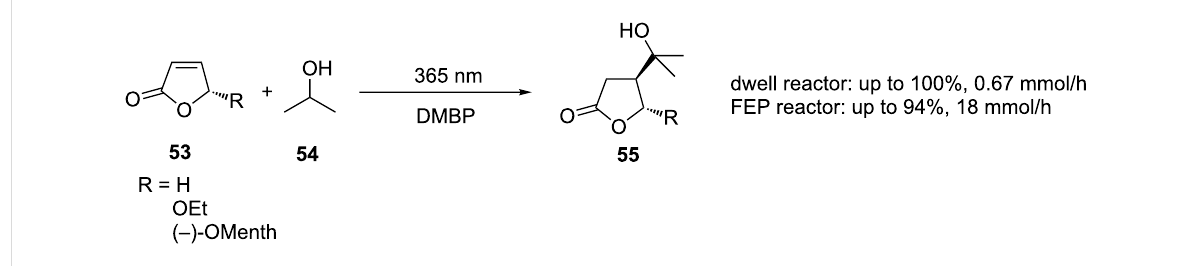
Scheme 17: Photochemical addition of isopropanol to furanones.